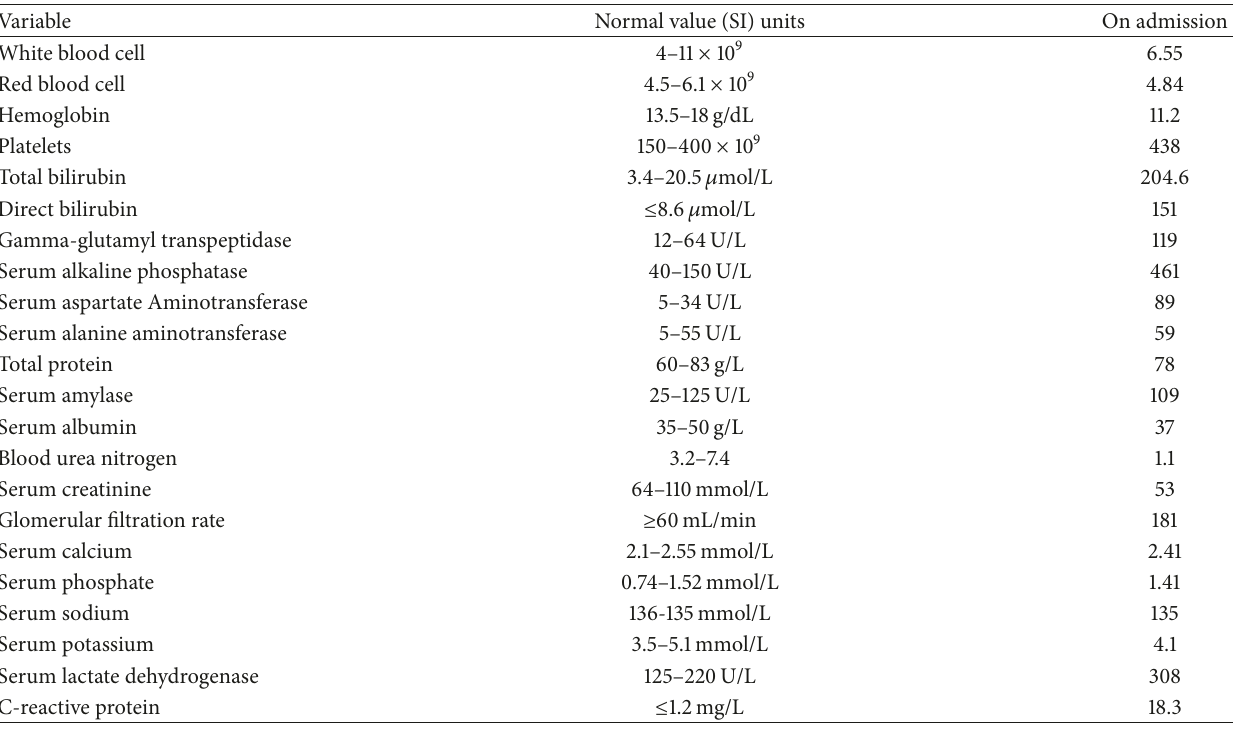
Table 1: Laboratory data in October, 2015.